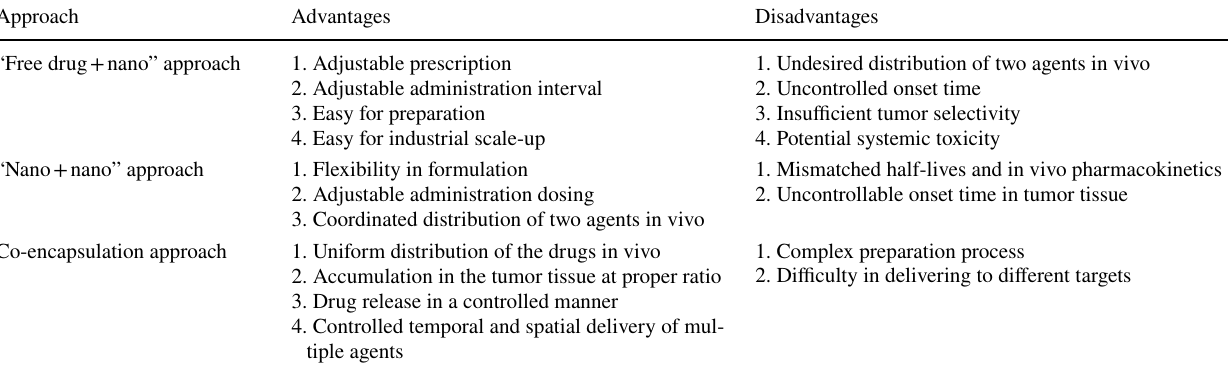
Table 3 Advantages and disadvantages of the three approaches in chemoimmunotherapy